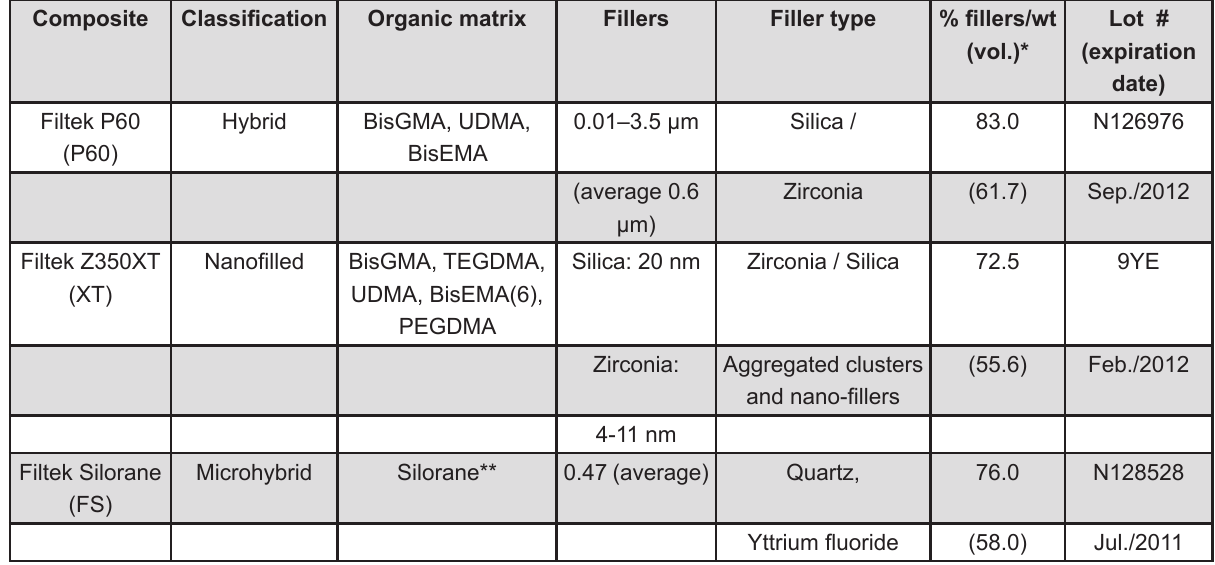
Figure 1- Description of the composites used in